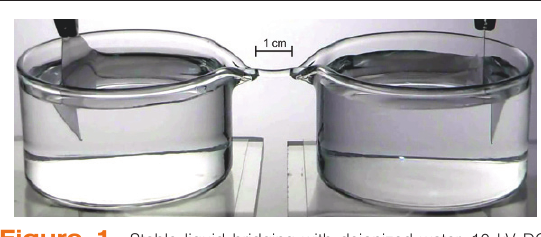
Figure 1. Stable liquid bridging with deionized water, 10 kV DC, 0.3 mA, Pt